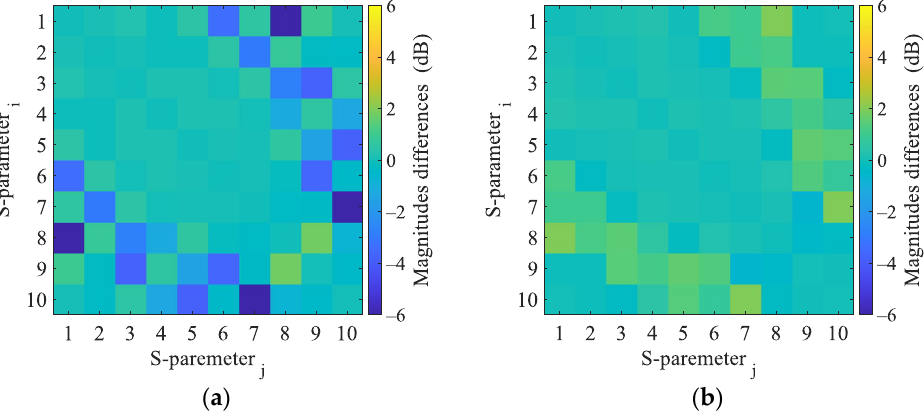
Figure A8. 2D numerical simulations. Magnitudes difference of 2D numerical model induced by the virtual presence of a 4 cm radius ( a ) hemorrhagic and ( b ) ischemic stroke located at position ( −2 0, 30).